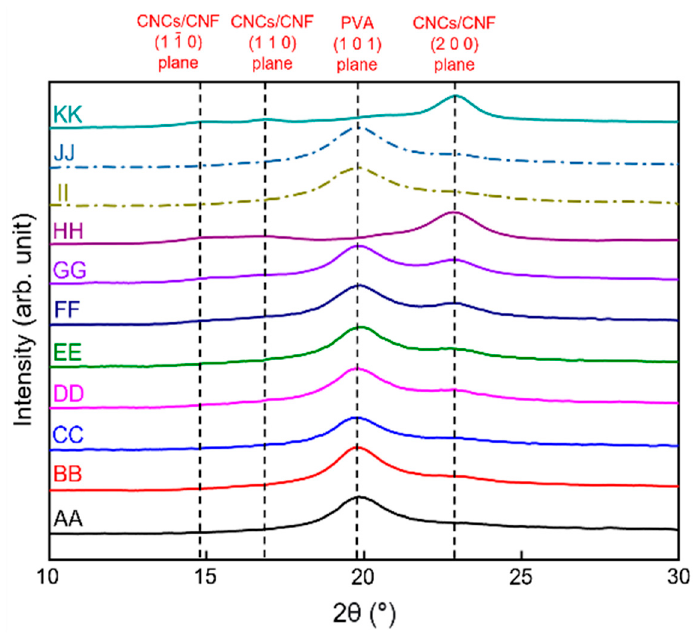
Figure 4. XRD patterns of the PVA + CNC/CNF nanocomposite films. The AA–KK notations are described henceforth. AA: Neat PVA, BB: PVA + 0.5 wt% CNCs, CC: PVA + 1.0 wt% CNCs, DD: PVA + 1.5 wt% CNCs, EE: PVA + 2.0 wt% CNCs, FF: PVA + 2.5 wt% CNCs, GG: PVA + 3.0 wt% CNCs, HH: Neat CNCs, II: PVA + 0.5 wt% CNFs, JJ: PVA + 1.0 wt% CNFs, and KK: Neat CNFs.